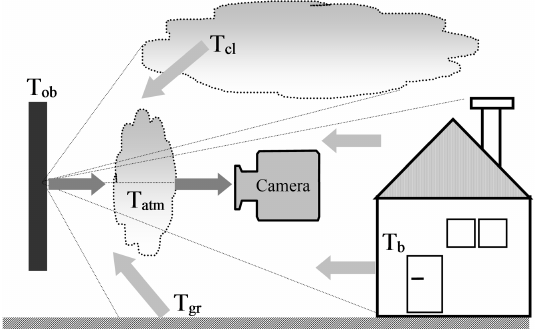
Figure 4. Explanation of simplifications assumed in the thermovi- sion camera measurement model (2, 3); ambient temperature T o is an average of temperatures of clouds T cl , atmosphere T atm , ground T gr and e.g. buildings T b (Minkina and Dudzik, 2009).